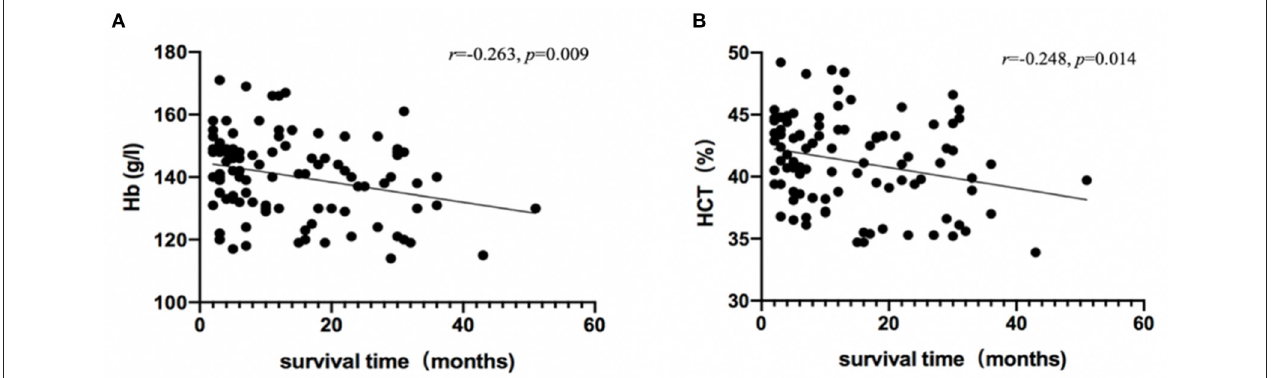
FIGURE 2 | Association between survival time and red cell indices. Hb (A) and HCT (B) levels in patients with CJD are plotted against survival time, and were analyzed using Spearman’s rho correlation analysis.